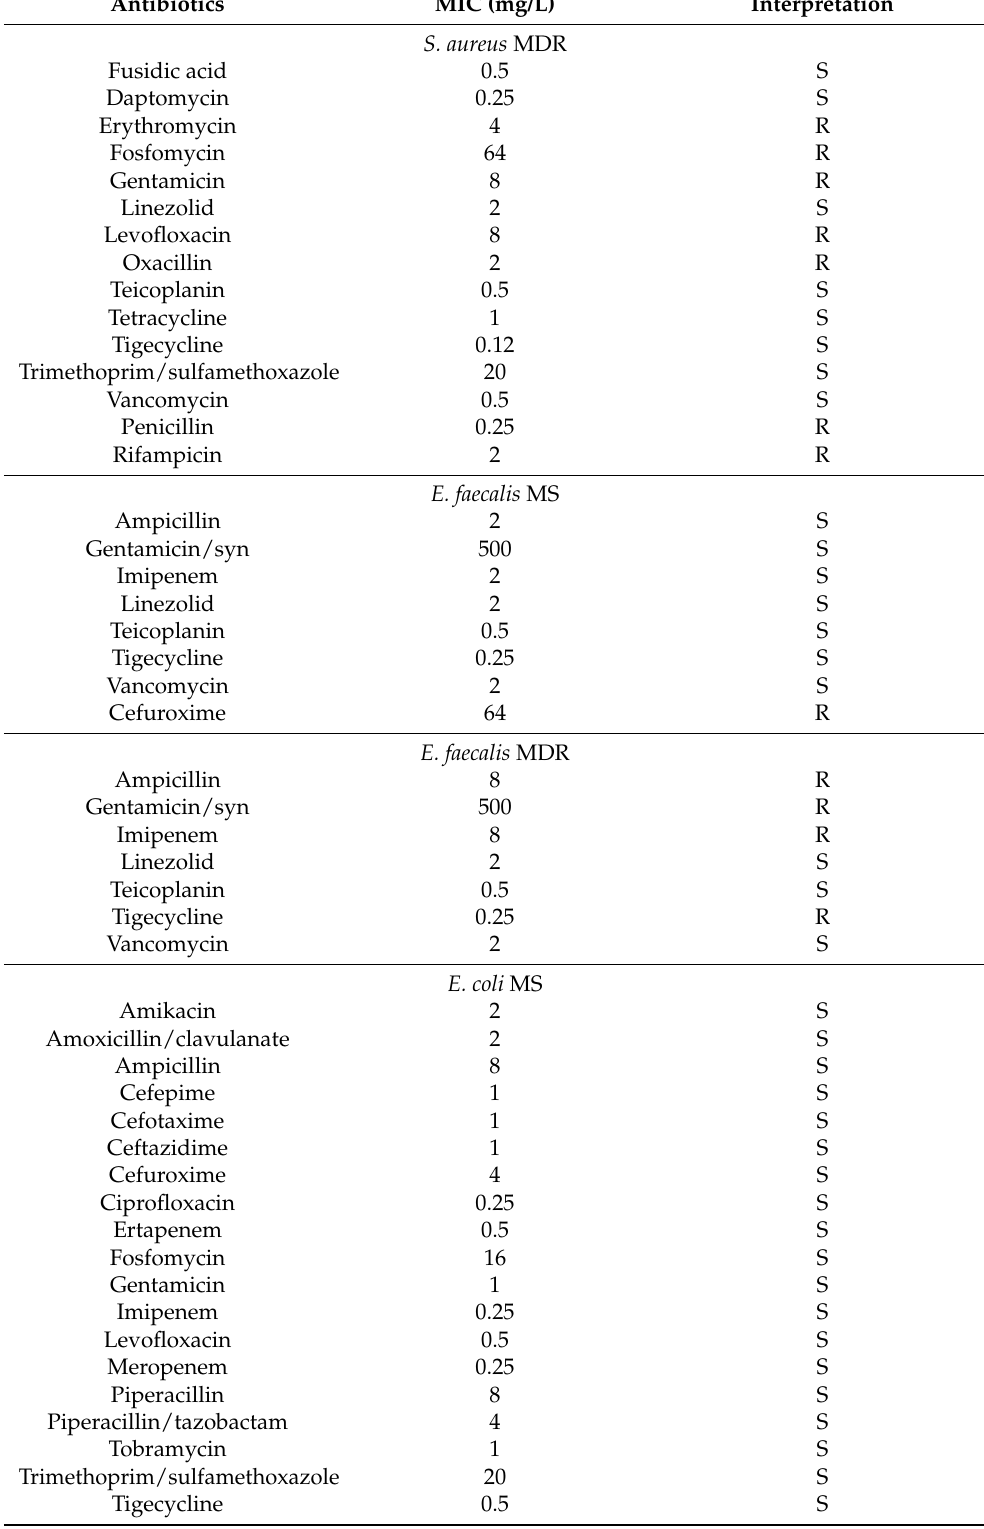
Table 2. Cont. Antibiotic Resistance Profile of the Clinical Isolated